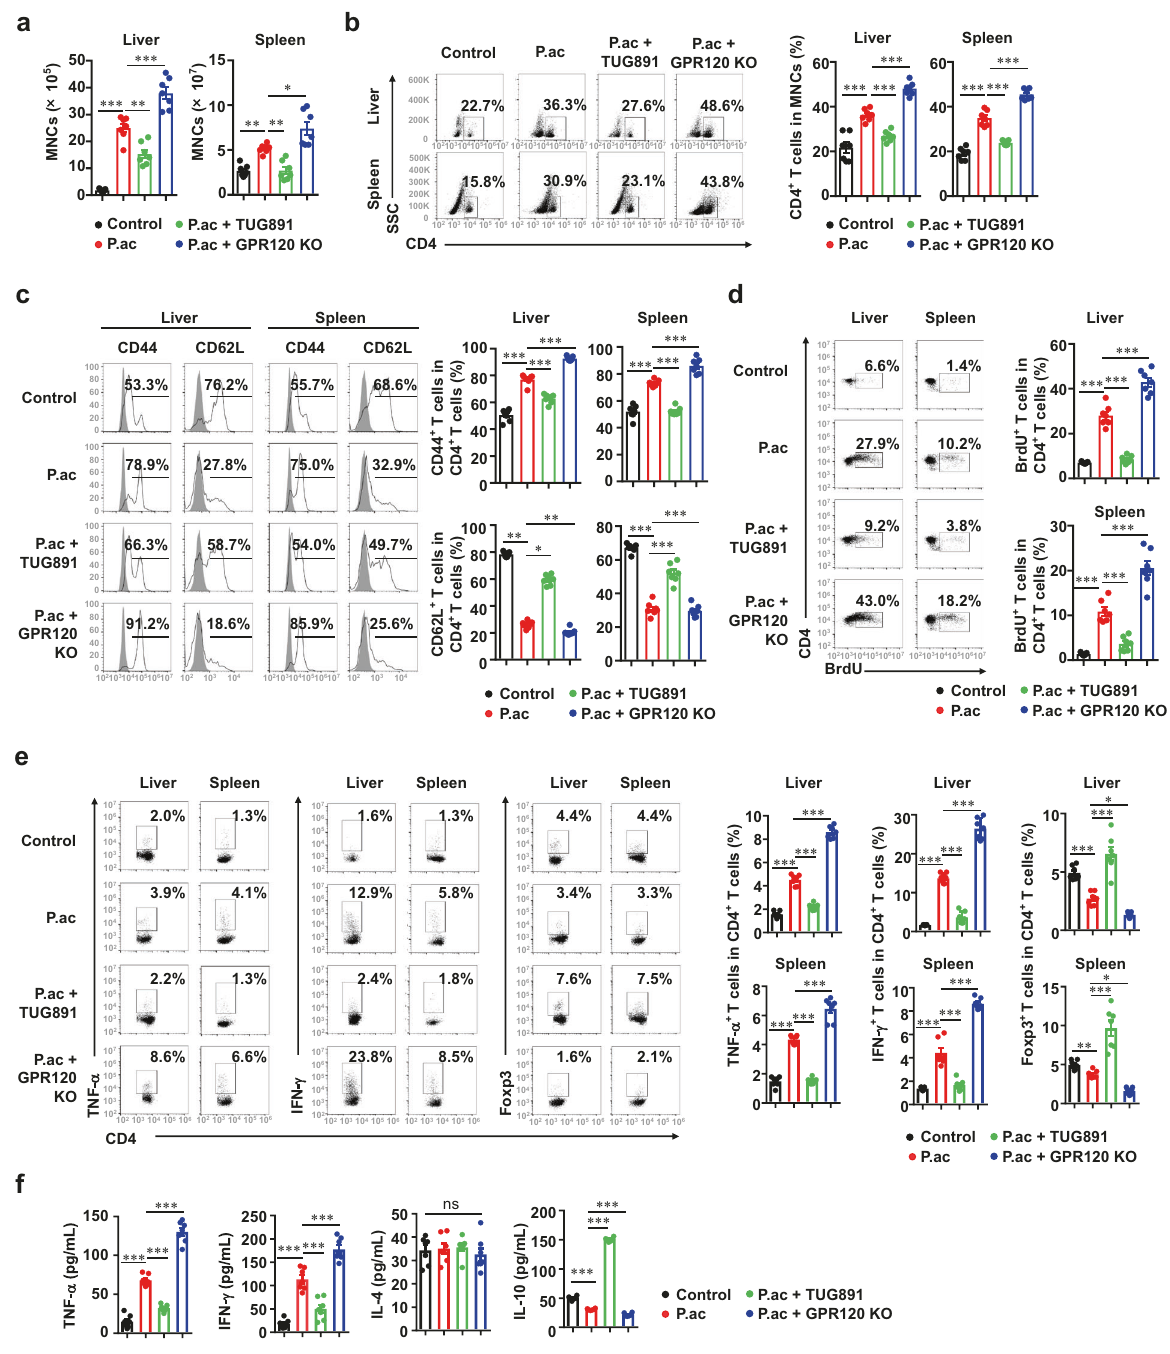
Fig. 2 GPR120 reduced CD4 + T cell responses in mice with liver injury. Wild-type (WT) and GPR120 − / − (GPR120 KO) mice were injected with P. acnes (P.ac). Vehicle or TUG891 (10 mg/kg) was administered i.p. to WT mice on days 0, 2, 4, and 6 after P. acnes injection. Livers and spleens were isolated on day 7 ( n = 7 mice per group). a Absolute numbers of total MNCs in livers and spleens were analyzed by fl ow cytometry. b Percentages of CD4 + T cells in total MNCs in livers and spleens were analyzed by fl ow cytometry. c The expression levels of CD44 and CD62L in CD4 + T cells in the livers and spleens were analyzed by fl ow cytometry. d On day 6 after priming, BrdU was injected i.p. into the mice. MNCs were isolated from livers and spleens the next day. Cells were stained for CD4 and BrdU. The frequencies of CD4 + BrdU + T cells in the livers and spleens were determined by fl ow cytometry. e The percentages of TNF- α + , IFN- γ + , and Foxp3 + cells in CD4 + T cells were assessed by intracellular staining and fl ow cytometry. f The levels of serum TNF- α , IFN- γ , IL-4 and IL-10 were measured by enzyme-linked immunosorbent assay. The results are representative of three to six independent experiments and presented as the mean ± SEM. Signi fi cant differences were analyzed by One-way ANOVA. * p < 0.05, ** p < 0.01, *** p < 0.001, ns no signi fi cance.